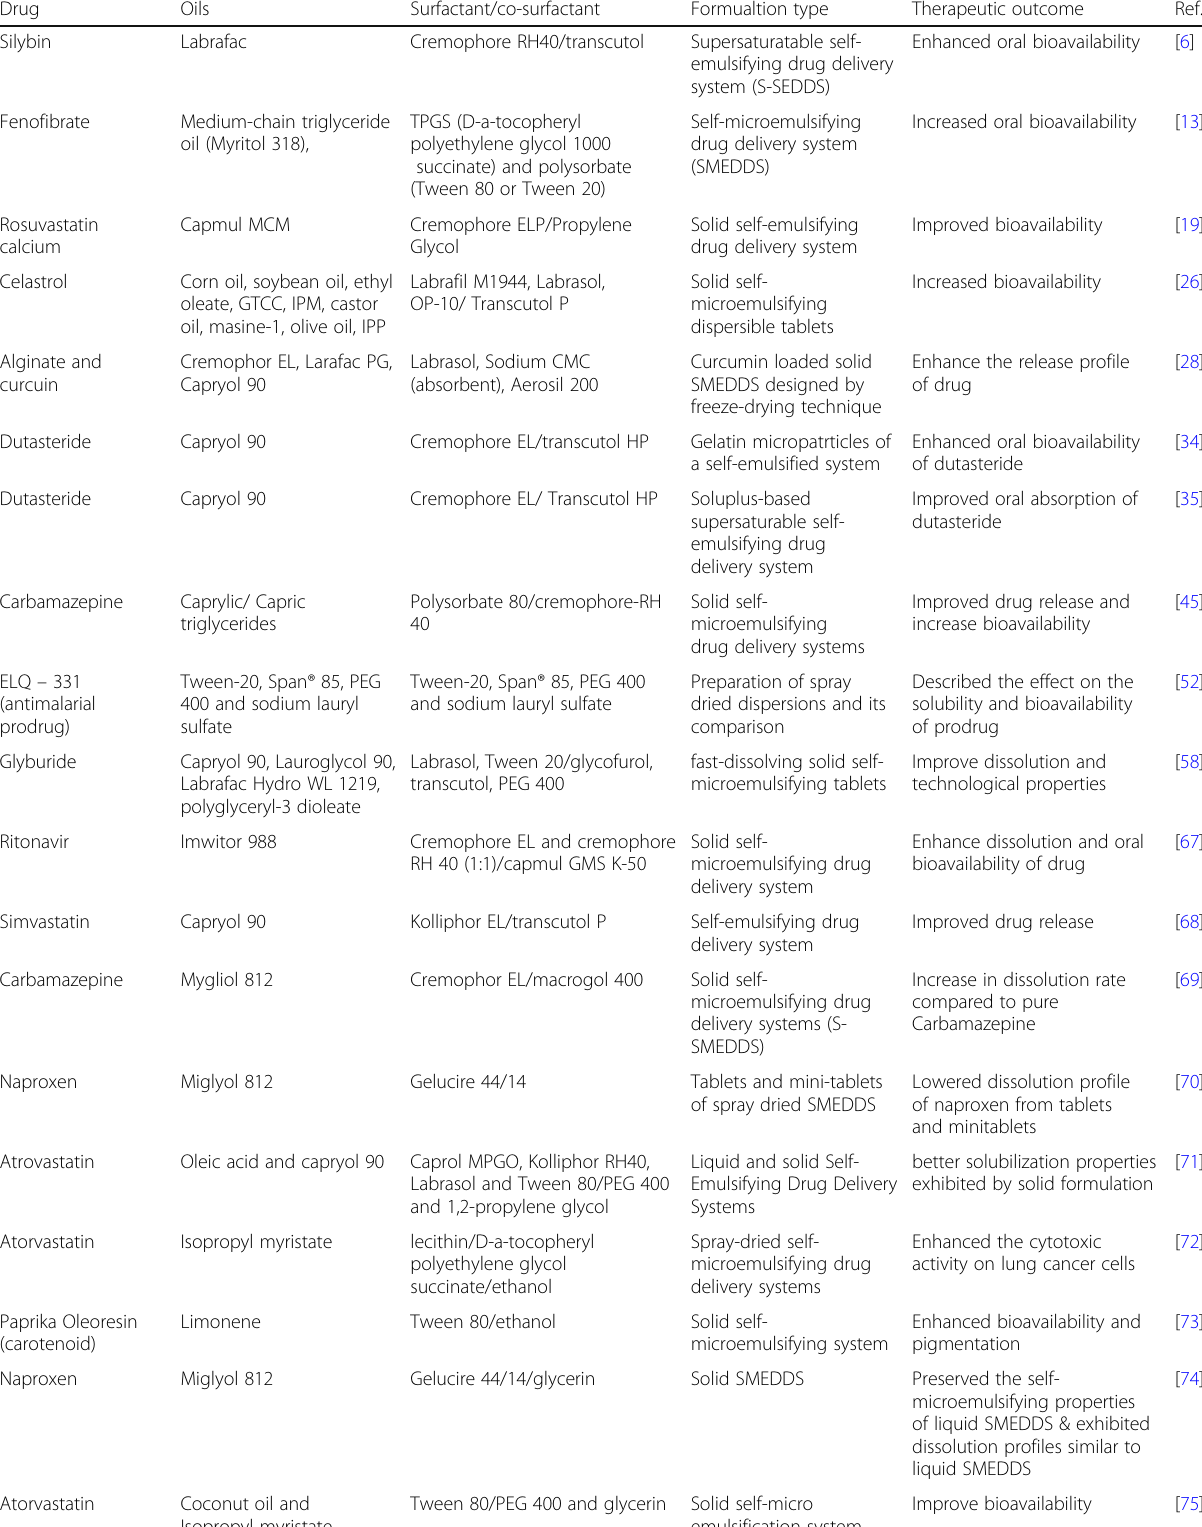
Table 3 List of drugs formulated as solid/liquid self-micro emulsified drug delivery systems (SMEDDS)